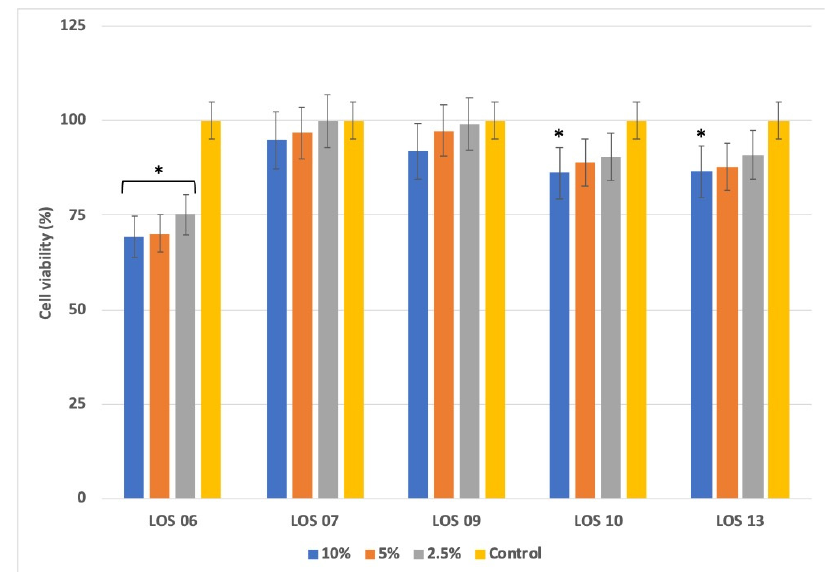
Figure 3. Human HaCaT cell toxicity in soil leachates and control. X-axis: Leachate concentration (% v / v ) in each soil sample site: Y-axis: Cell viability expressed as percentage (%). Values indicate the mean ± SD in three independent experiments. The ANOVA has been made between “% leachate” vs. Control inside each sampling point. Asterisk indicates significant difference in HaCaT cell viability between samples and control (Tukey’s post hoc test * p < 0.05).